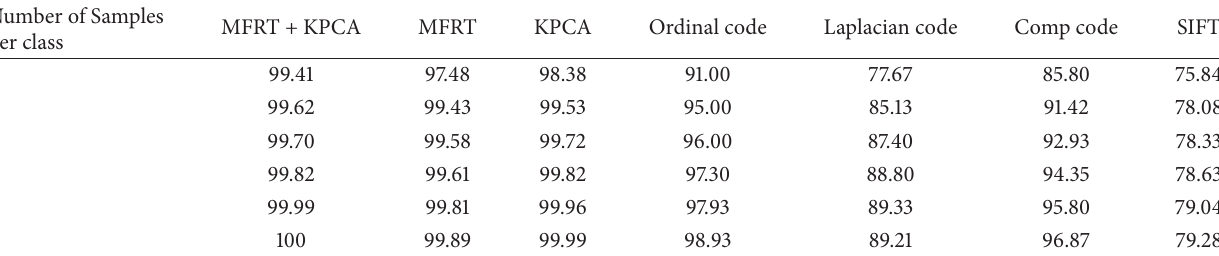
Table 4: Accuracy measures from Poly U left hand multispectral palm print image.